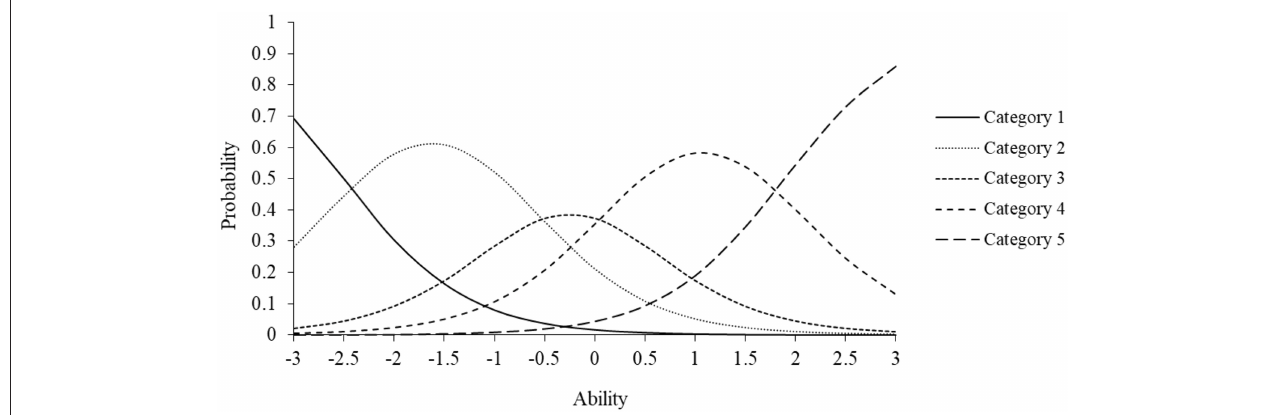
FIGURE 2 | Item characteristic curve for polytomously scored